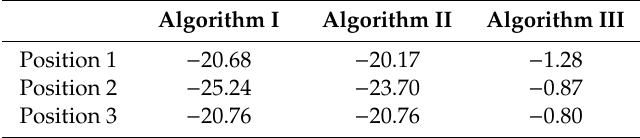
Table 2. The gain of Algorithm I, II, and III processed results relative to the standard input